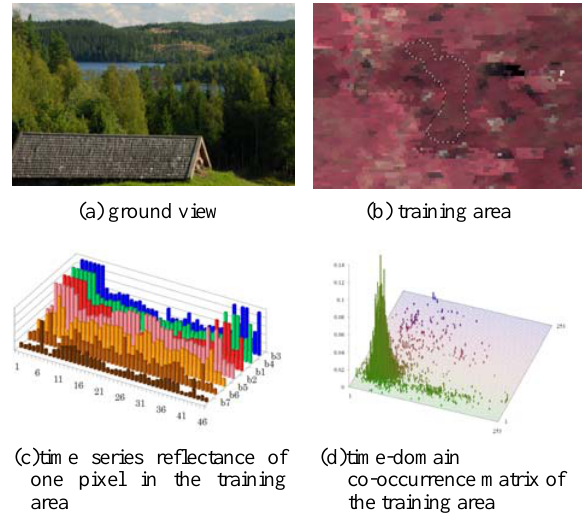
Figure 4. Training data example for "evergreen needleleaf forest".